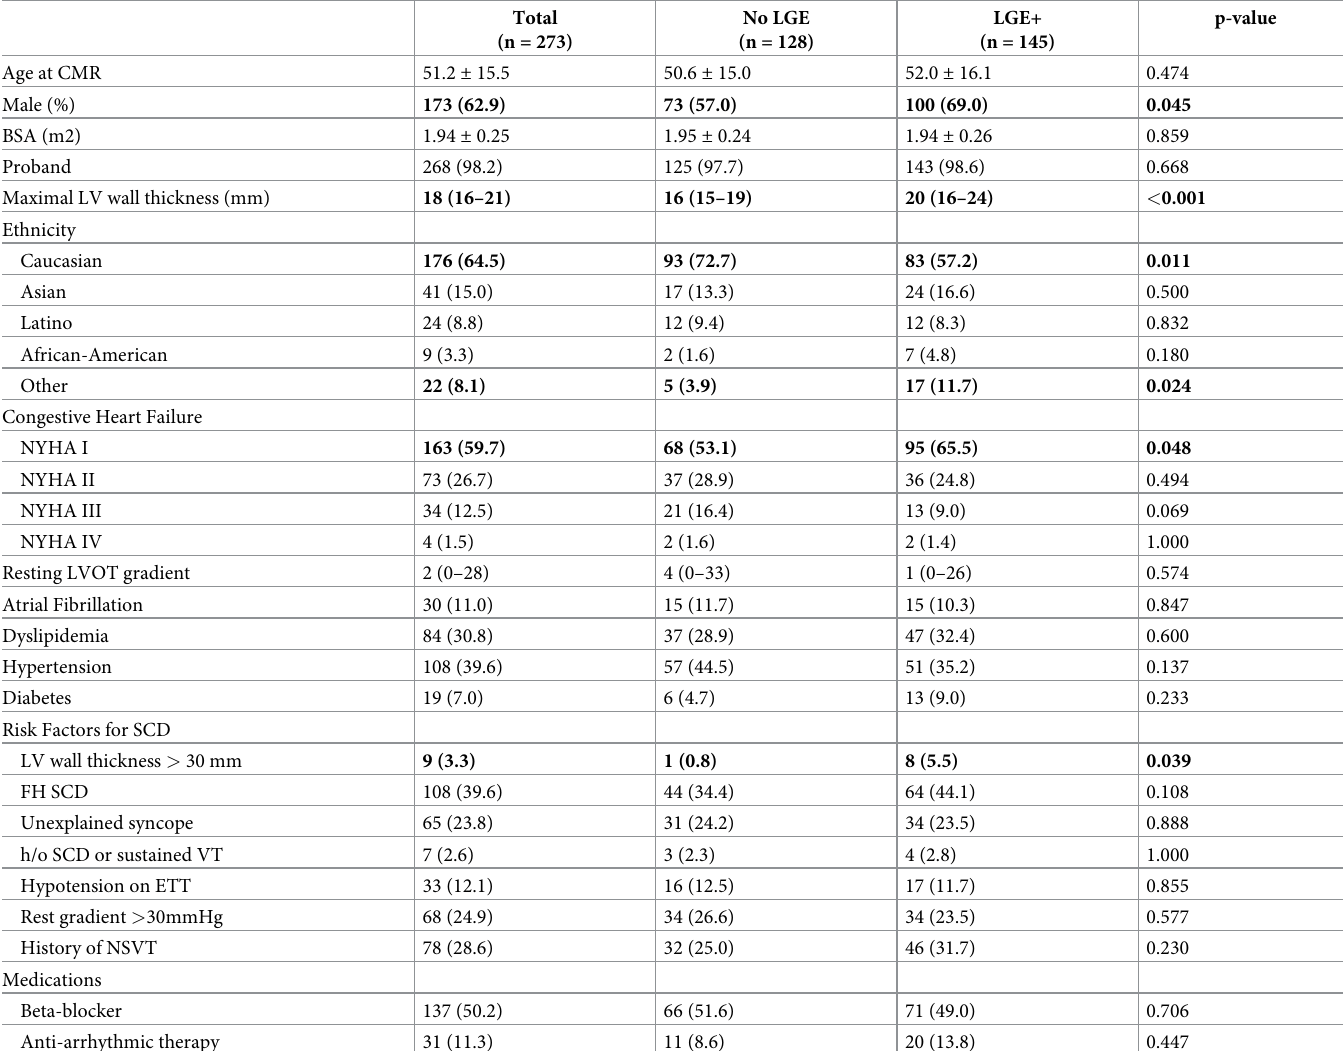
Table 1. Baseline population